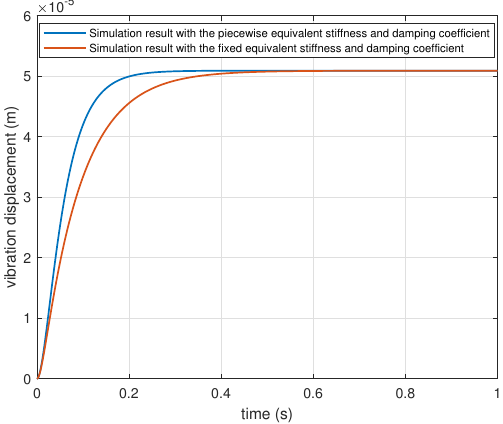
Figure 8. Simulation results of two active control